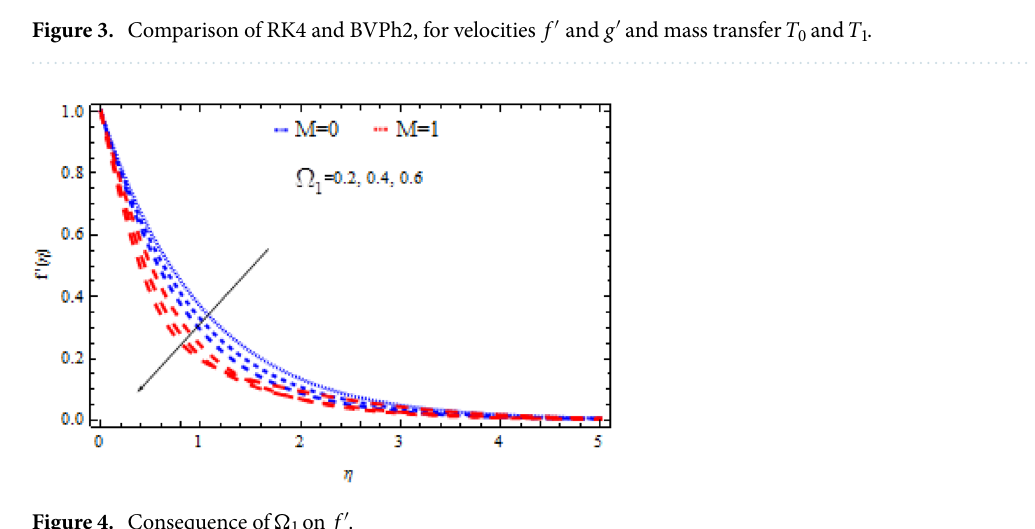
Figure 4. Consequence of (cid:31) 1 on f ′